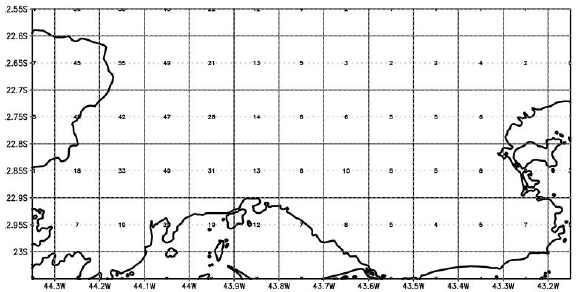
Figure 1. The study region location latitudes 22º 55’ 56” S, 23º